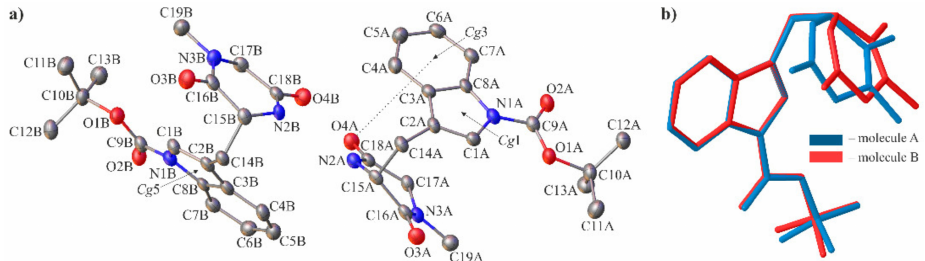
Figure 2. Asymmetric unit of the crystal lattice with crystallographic numbering ( a ) and superim- posed molecules of 11a ( b ). Displacement ellipsoids are drawn at the 50% probability level and the H-atoms were omitted for clarity. The intramolecular C=O · · · π contact is represented by the dotted line. Cg 1, Cg 3 and Cg 5 denote the geometric centres of gravity of the aromatic rings delineated by the N1A/C1A–C3A/C8A, C3A–C8A and N1B/C1B–C3B/C8B atoms,